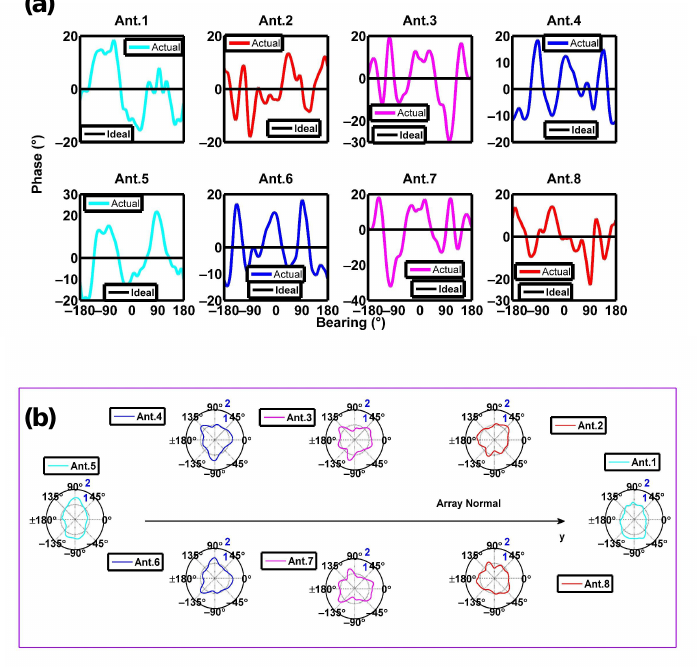
Figure 9. Phase patterns of the eight antennas: ( a ) γ m ( θ ) in Cartesian coordinates, where “Ideal” and “Actual” denote uncalibrated and calibrated antenna patterns, respectively; ( b ) e γ m ( θ ) in polar coordinates. Each bearing of − 180 ◦ ≤ θ < 180 ◦ in this figure indicates degrees counterclockwise from the y axis.